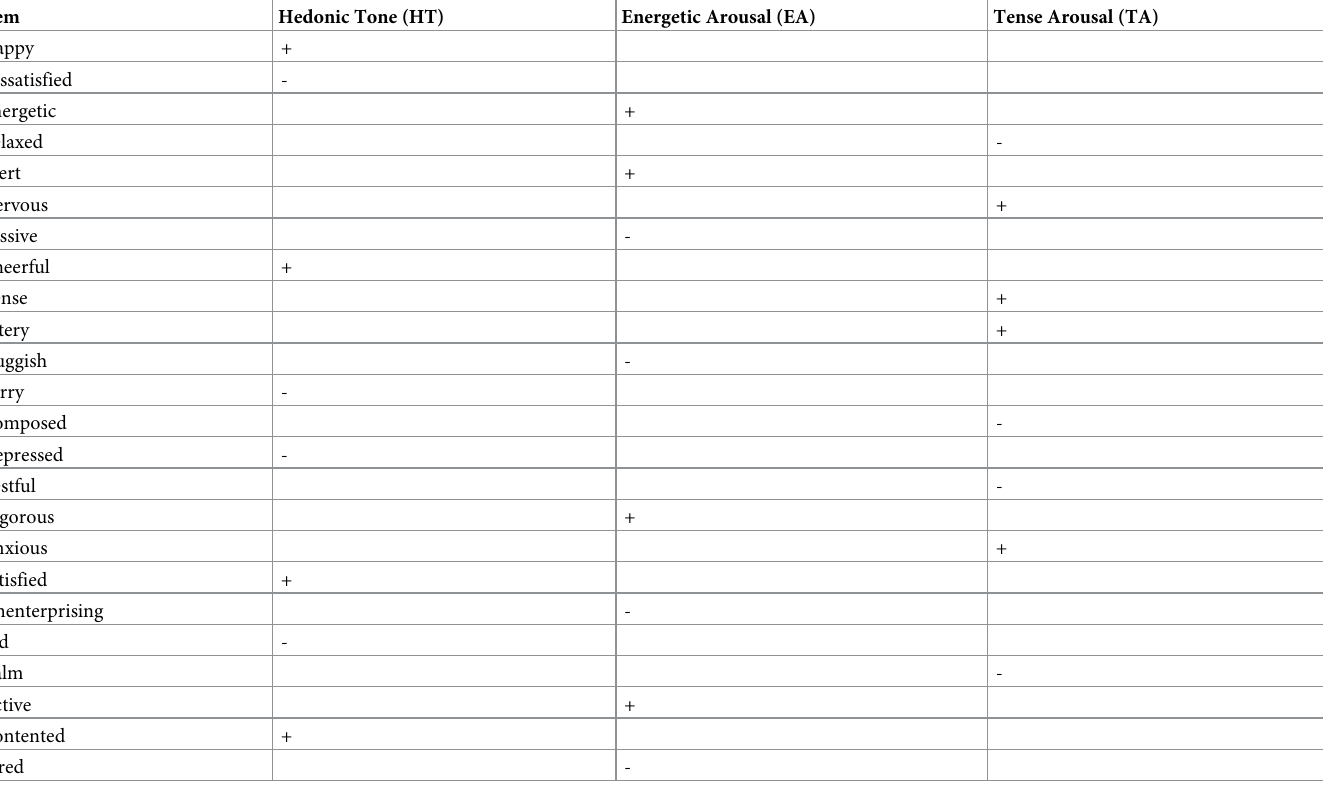
Table 1. University of Wales Institute of science and technology mood adjective checklist (UMACL) for assessment of the psychological parameters of zoo visitors’